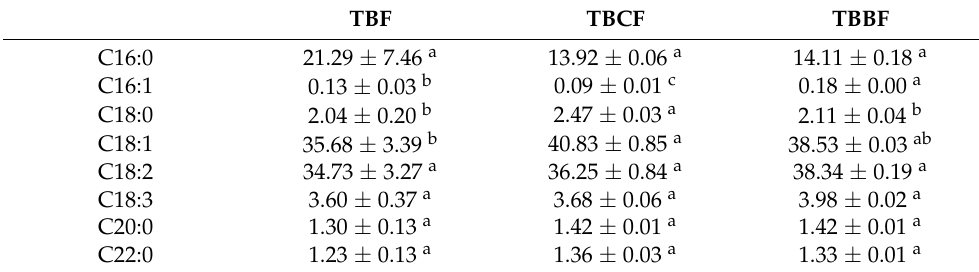
Table 2. Fatty acid composition (%) of TBF, TBCF, and TBBF.